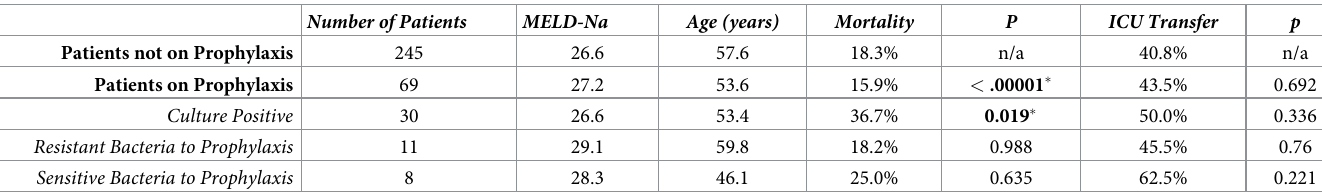
Table 5. Analysis of patients on prophylactic